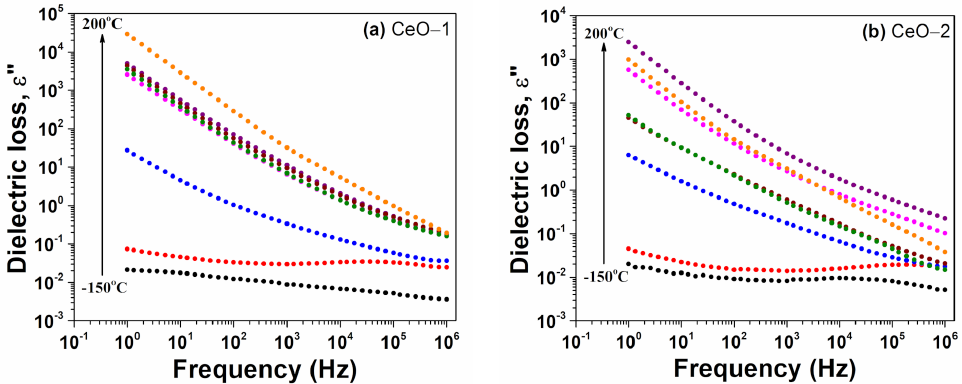
Figure 8. Dielectric loss dependence on frequency at various temperatures for cerium oxide nanopar- ticles: ( a ) CeO-1, ( b ) CeO-2.